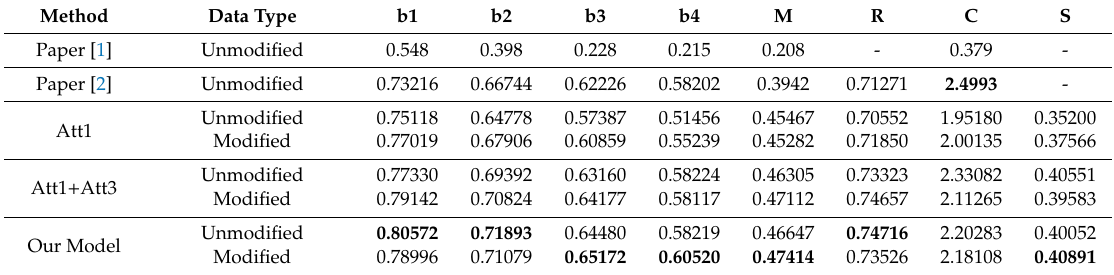
Table 3. The comparison of di ff erent methods on the unmodified and modified datasets of Sydney. The bold value is the highest